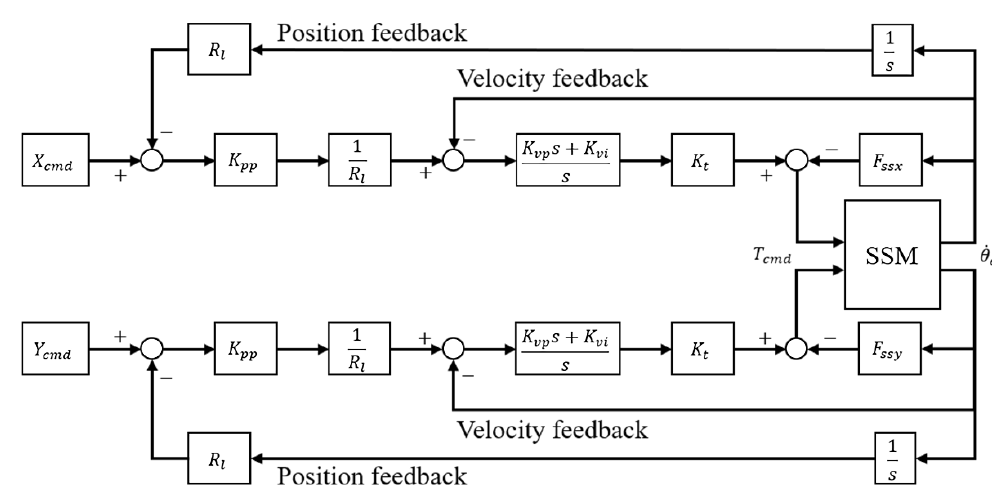
Machines 2022 , 10 , x FOR PEER REVIEW Figure 15. Block diagram of controller and the proposed machine tool model. Figure 15. Block diagram of controller and the proposed machine tool model.